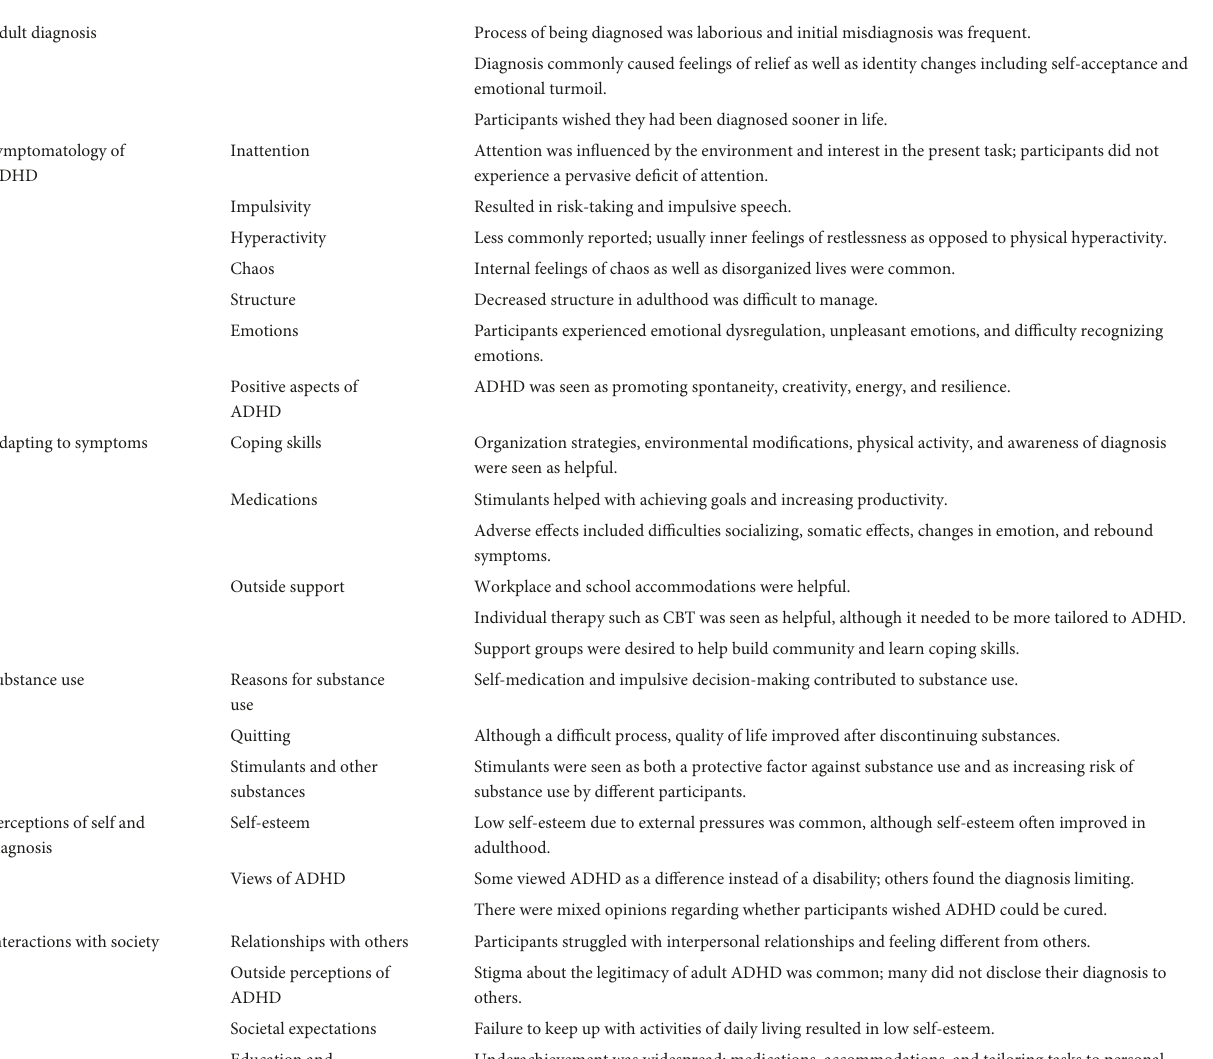
TABLE 2 Summary of